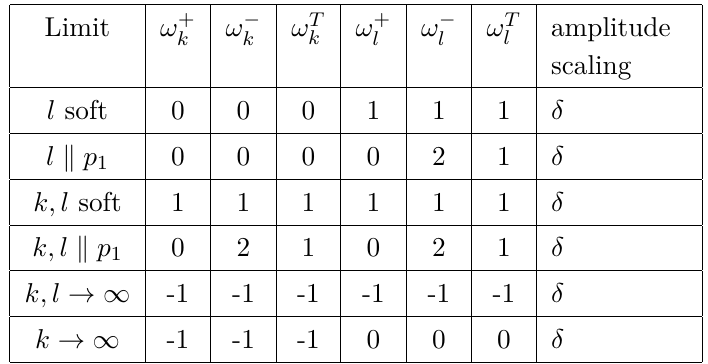
Table 2. The scaling behavior of the vacuum polarization contributions to the finite integrand (2) in various limits. The loop momenta k and l are parameterized as eq. (6.5), with the scaling f M 2 exponents given in this table. The scaling of the integration measure has been taken into account. Since the integrals always scale as δ raised to a positive power, there is no divergence in any of the IR / UV limits.